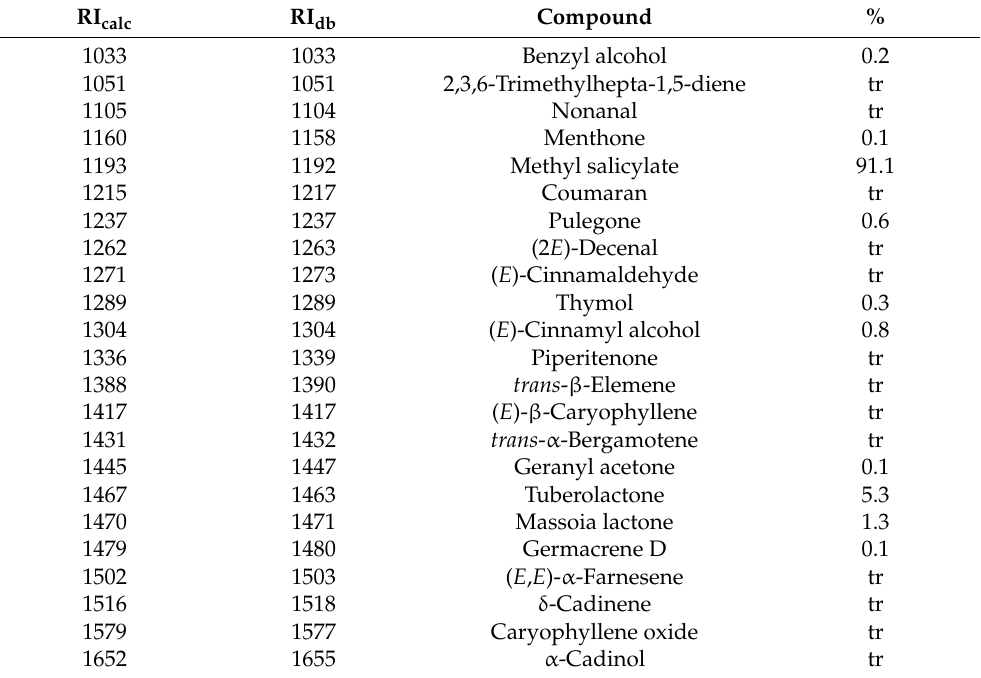
Table 3. Essential oil composition of American wintergreen ( Gaultheria procumbens ) cultivated in southern